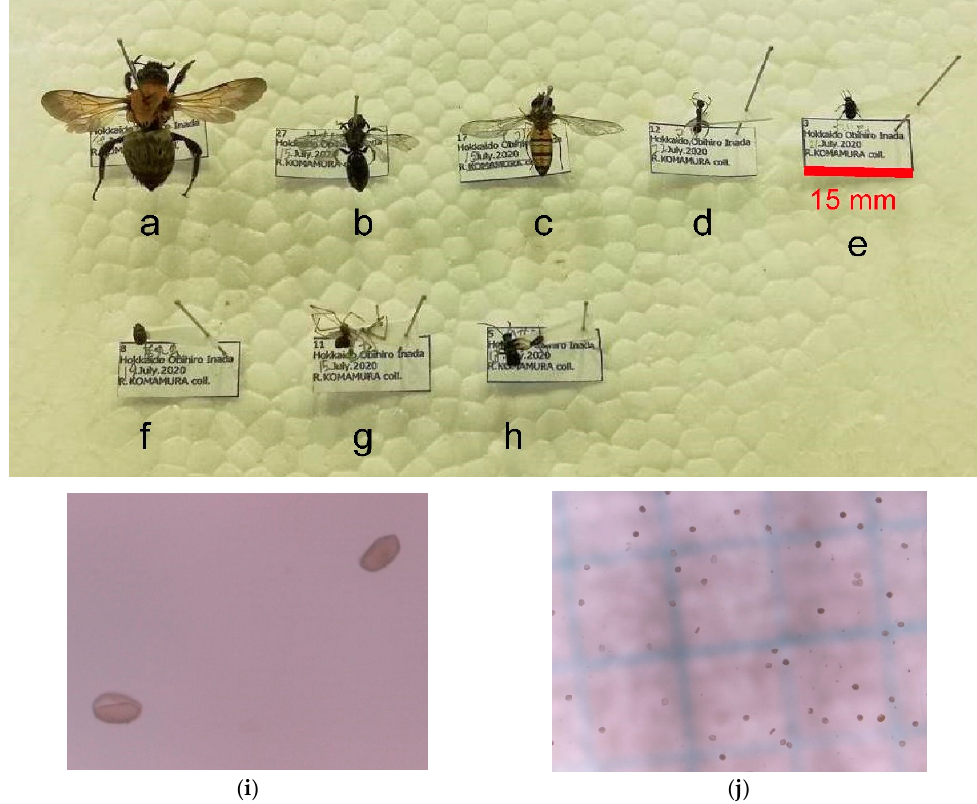
Figure 2. Different species visiting the flowers of Cardiocrinum cordatum (Thunb.) Makino. ( a ) A bumblebee ( Bombus diversus tersatus ), ( b ) a sweat bee ( Halictidae sp.), ( c ) a marmalade hoverfly ( Episyrphus balteatus ), ( d ) an ant ( Myrmica ruginodis (s.l.)), ( e ) a leaf beetle ( Chrysomelidae sp.), ( f ) a sap beetle ( Nitidulidae sp.), ( g ) a spider ( Araneae sp.), and ( h ) an earwig ( Dermaptera sp.). ( i , j ) Pollen grains of C. cordatum were observed during the counting. The photographs were taken by Riko Koma- mura in 2020. The original high-resolution images are available as Supplementary